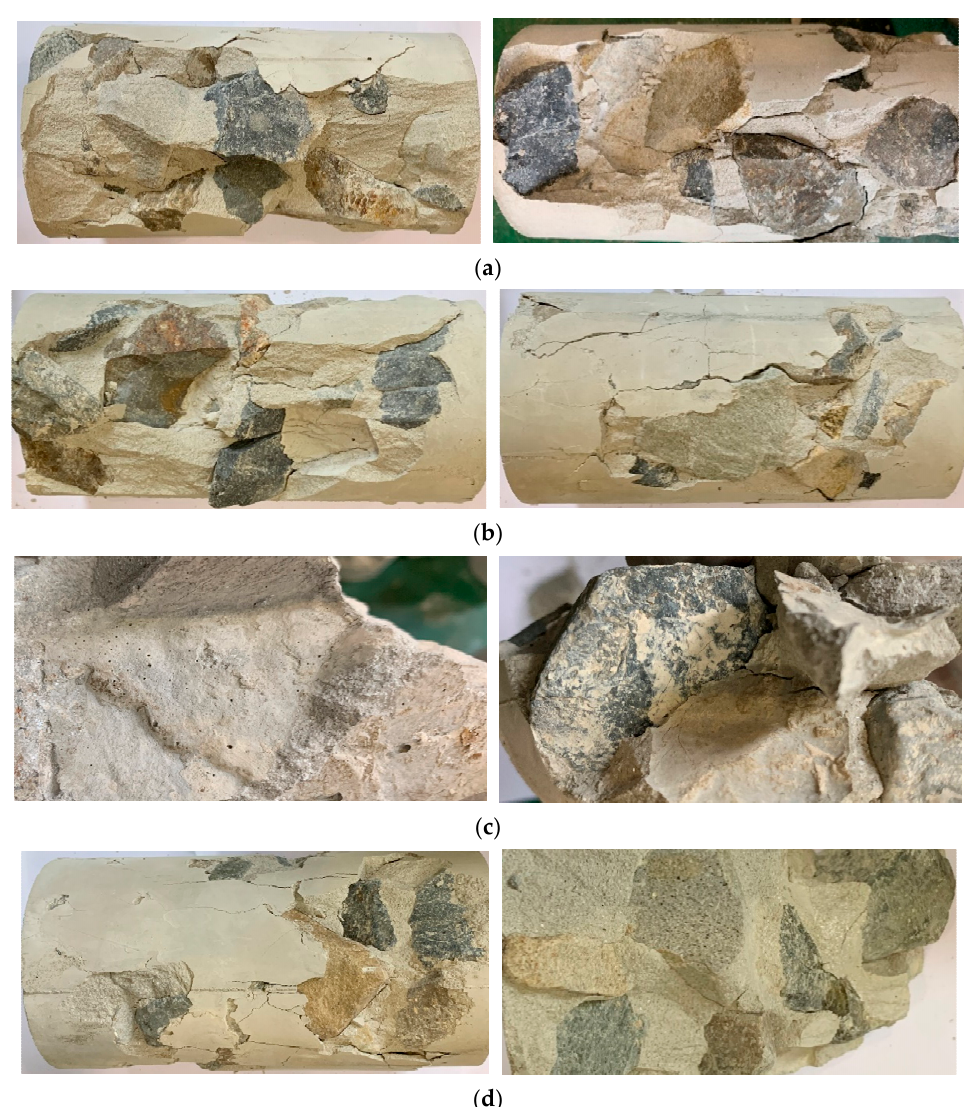
Figure 9. Failure surface of concrete specimens after compressive tests; ( a ) C-0-0, ( b ) C-0-100, ( c ) C-15-0, ( d ) C-15-100.